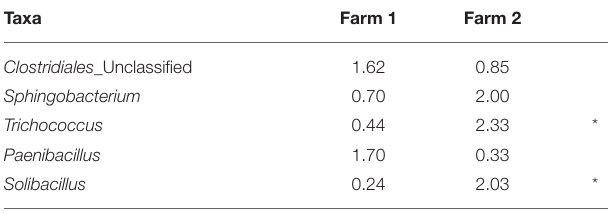
TABLE 4 | Mean relative abundance (%) of dominant genus-level taxa ( > 1% of total OTUs) of fecal microbiomes at three timepoints from two pastured poultry broiler flocks a,b .